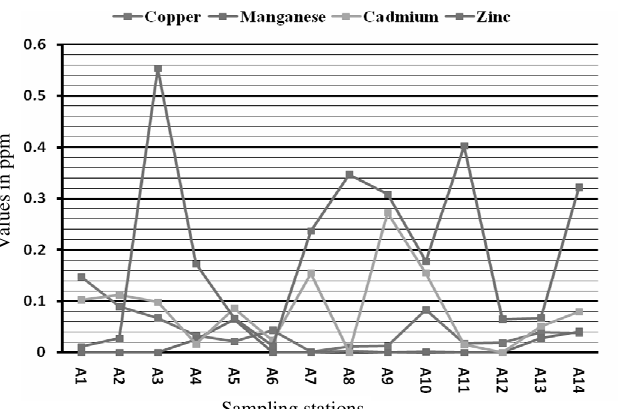
Figure 2. Variation of metal contents of groundwater inside the tea